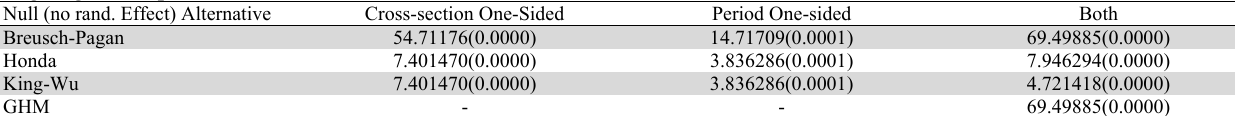
Langrange Multiplier .